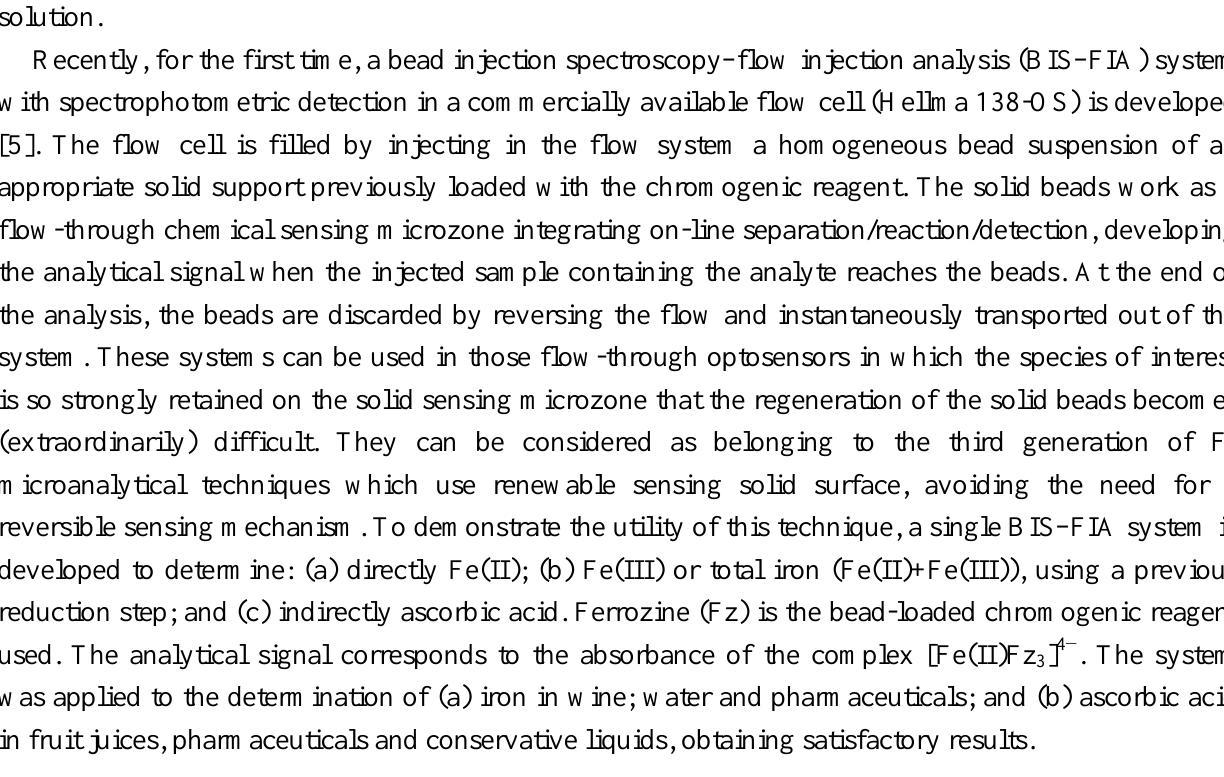
Table 1 . Methods based on flow-through UV/VIS sensors.